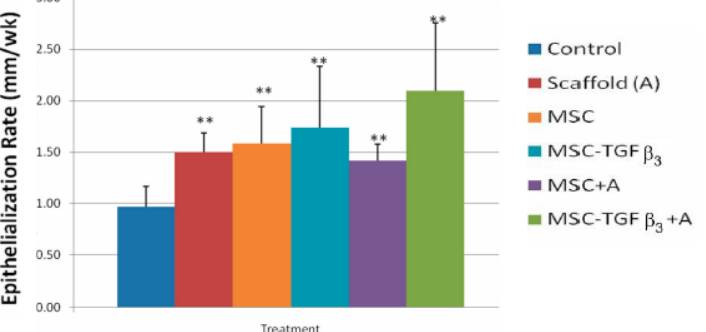
Figure 7. Epithelialization rates two weeks following surgery. ** indicates statistical significance between treatment and control. ** indicates statistical significance between two treatments ( p < 0.05) [22].